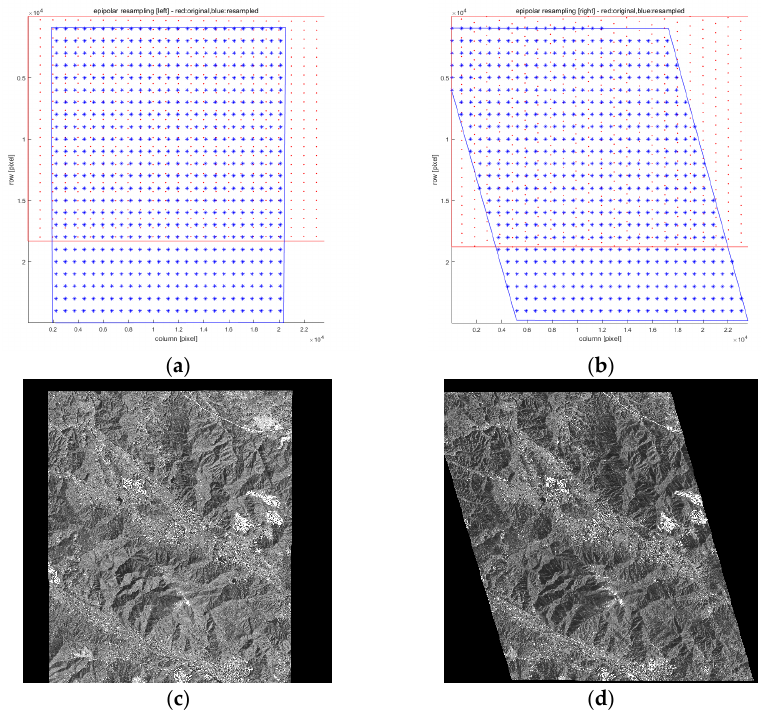
Figure 5. Epipolar image resampling of Kompsat-3 along-track stereo images: ( a , c ) K3-944 (red dots: original image points, blue dots: resampled image points), ( b , d ) K3-102.